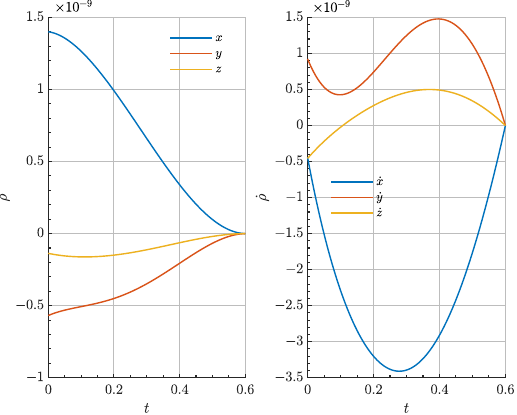
Figure 16. Evolution of the relative state vector components for the JWST servicing spacecraft during the final close-range rendezvous.